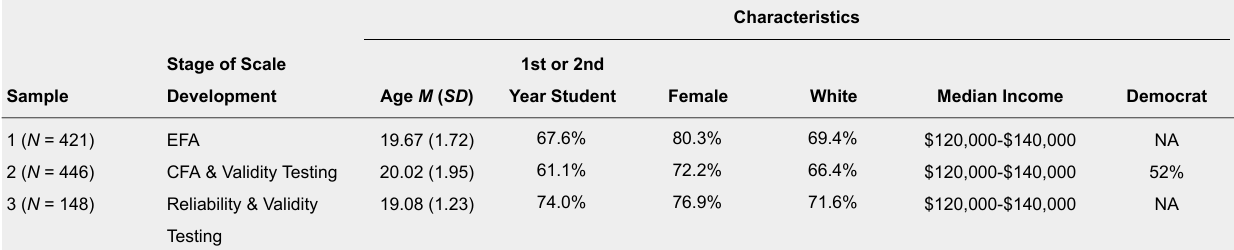
Sample Characteristics